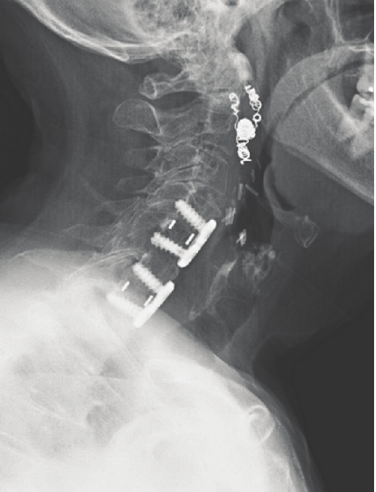
Figure 2: Postoperative lateral radiograph showing fixation at 9 months. (Please note: clips and coils postembolization of the occipital and external carotid arteries apparent in the anterolateral left